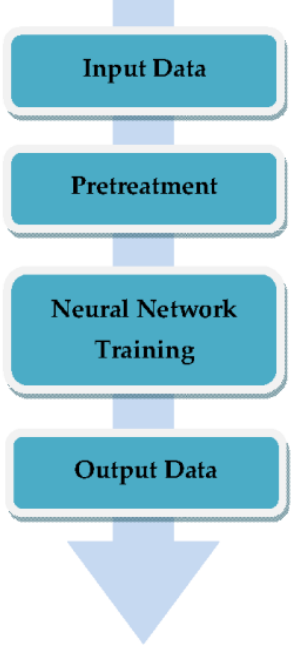
Figure 4. Dataset preprocessing phase.